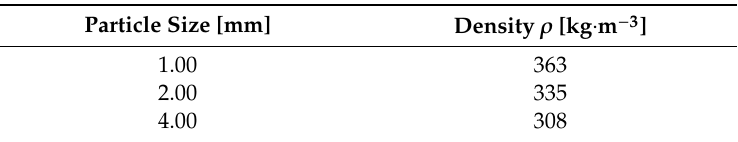
Figure 16. Numerical model used in the simulation. Table 3. Input parameters of snow. Table 3. Input parameters of snow.